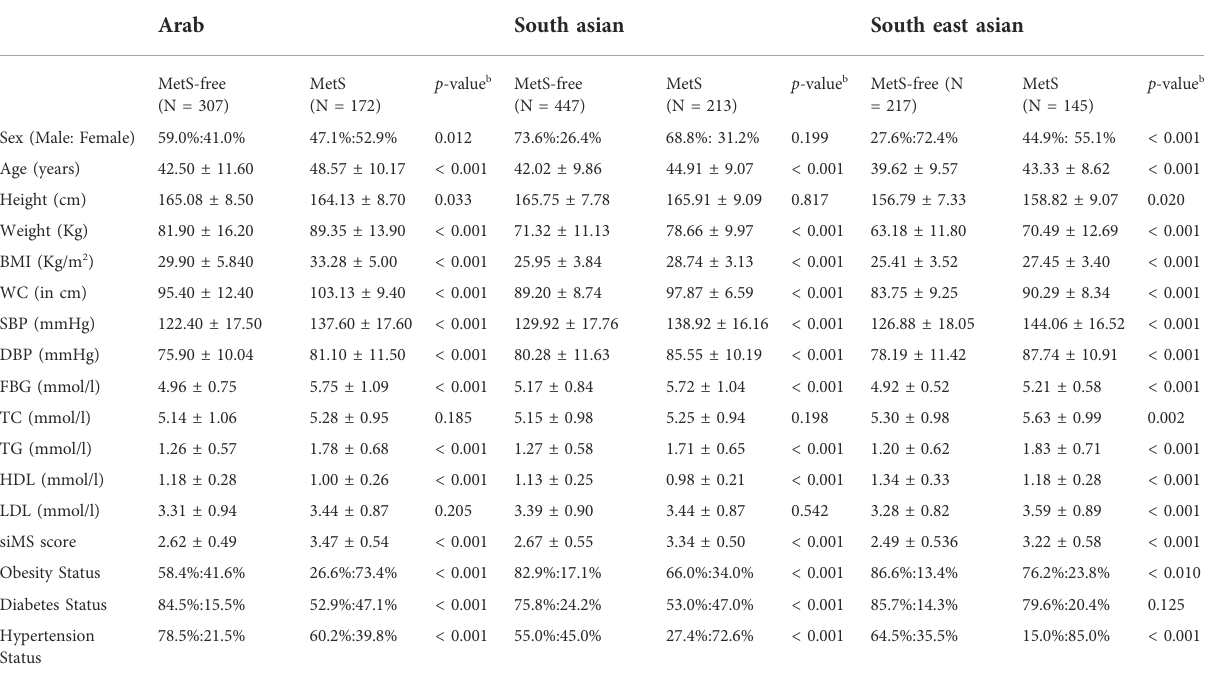
TABLE 1 Descriptive statistics for MetS and MetS-free individuals in the study cohorts of Arab, South Asian and South East Asian individuals from Kuwait.